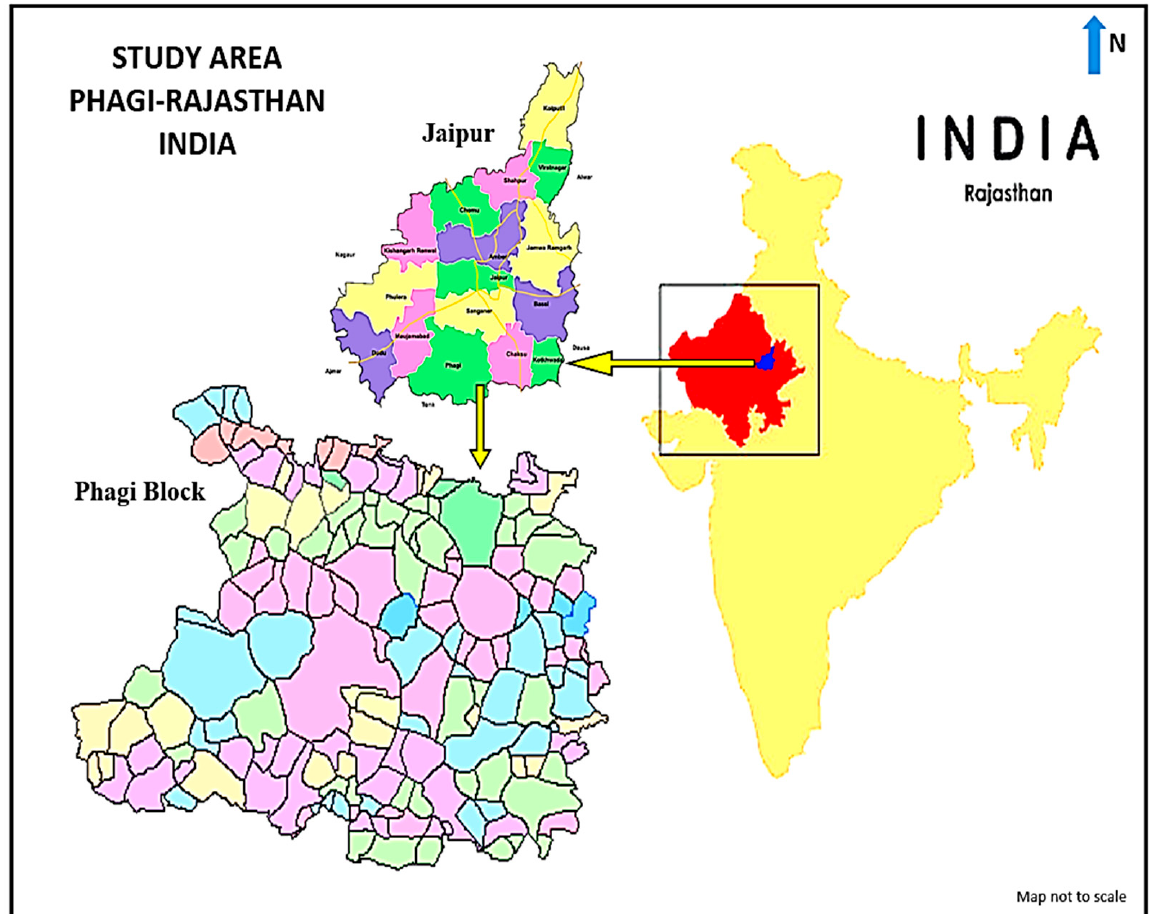
Figure 1. Study Area—Location map (Source—Primary Data).